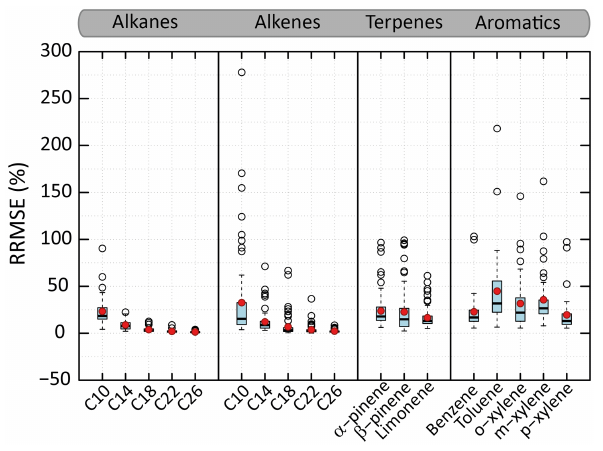
Figure 7. Distributions of the RRMSE on organic aerosol mass con- centration calculated between VBS-GECKO and GECKO-A on the learning simulations. The bottom and top of the boxes are the first and third quartiles; the bands inside the boxes represent the me- dians. The ends of the whiskers represent the lowest RRMSE still within 1.5 times the interquartile range (IQR) of the lower quartiles and the highest RRMSE still within 1.5 IQR of the upper quartiles. Red points represent the mean values and empty points the outliers. There are 45 simulations for n-alkane or aromatics and 70 for 1- alkene or terpene. Time steps for which the OA mass simulated with GECKO-A is under a threshold of 5 × 10 − 5 µgm − 3 (i.e. a SOA yield lower than around 1%) are not considered in RRMSE